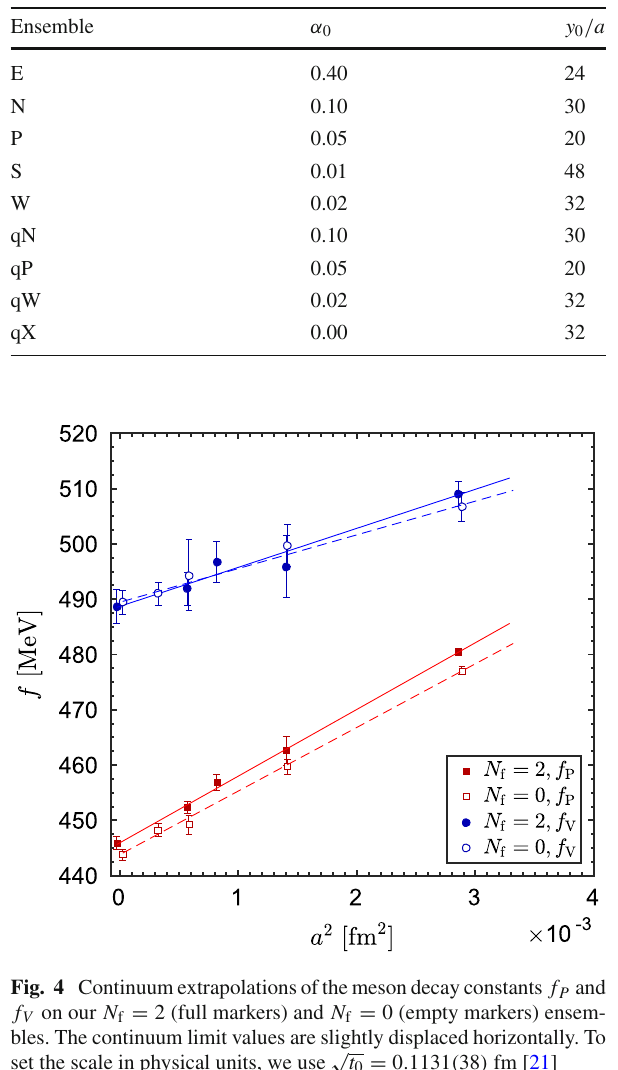
Fig. 3 Tuning of the parameter α 0 of the distance preconditioning method for our coarsest lattice ( N f = 2, β = 5 . 3, see Table 1). We show the relative local residual of the solution ψ as a function of the sink position x 0 with respect to the source set at y 0 / a = 16. On the right, the number of iterations for the solver to converge is reported for the values of α 0 plotted in the Figure Table 2 The table lists the values of the parameter α 0 for the distance preconditioning of the Dirac operator and the time-slice of the source position used to determine R P and R A used for the ensemble qX